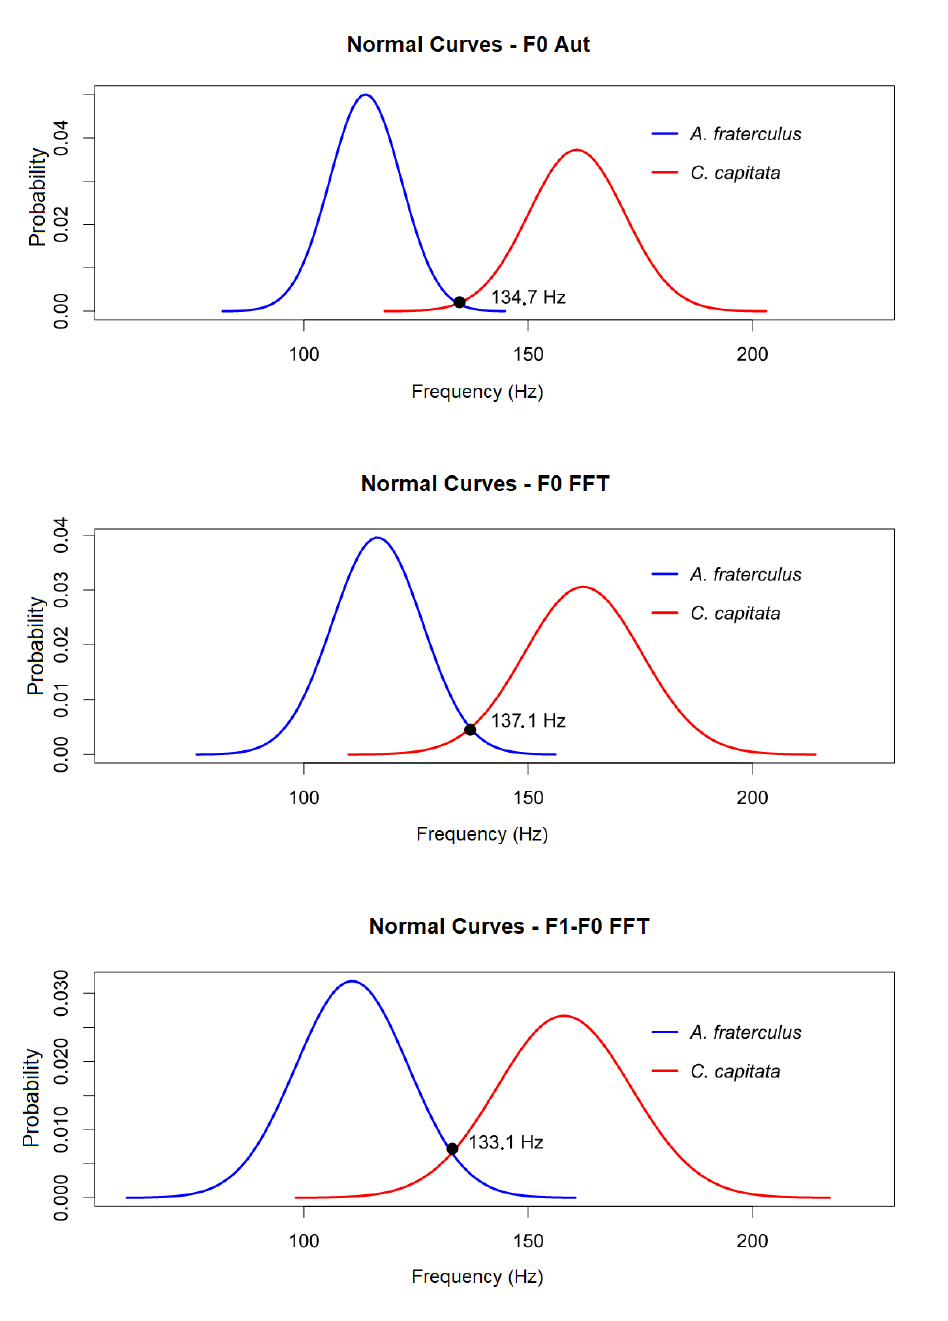
Figure 26. Comparison between the normal curves for fundamental frequency by the CAEA algorithm (autocorrelation method) (F0 Aut.), fundamental frequency by the CAEA algorithm (FFT method) (F0 FFT) and frequency by the difference between the frequencies of the 2nd component and the fundamental frequency by the CAEA algorithm (FFT method) (F1-F0 FFT) of the events of passage of C. capitata of the standard group and A. fraterculus of the standard